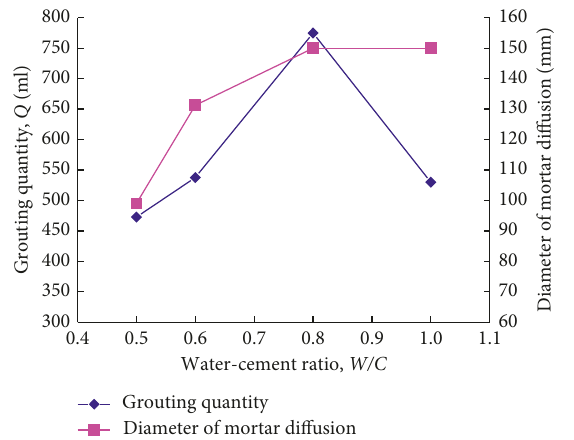
Figure 18: Characteristics of slurry diffusion ( P � 0.3MPa, k 2 � 0.13cm/s).